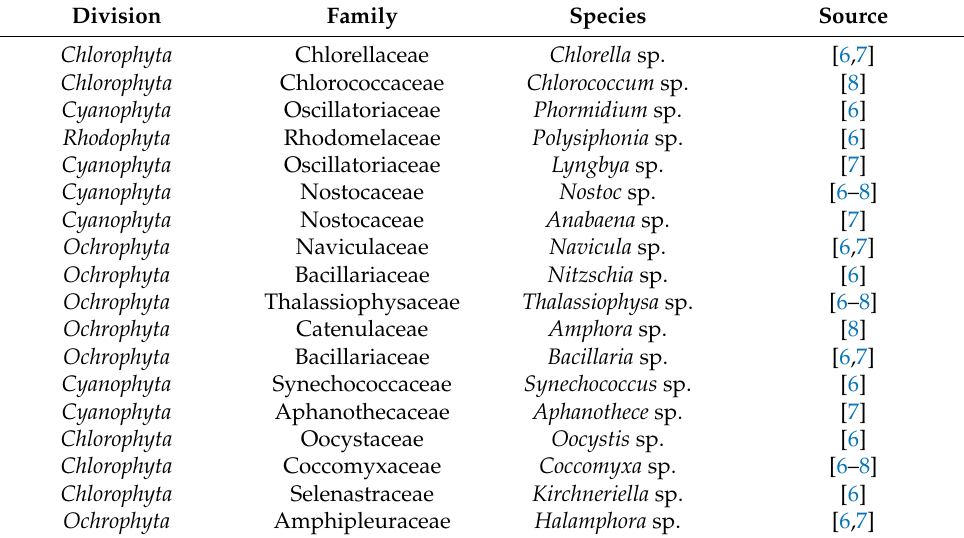
Chlorophyta Oocystis sp. Chlorophyta Coccomyxaceae Coccomyxa sp. Chlorophyta Selenastraceae